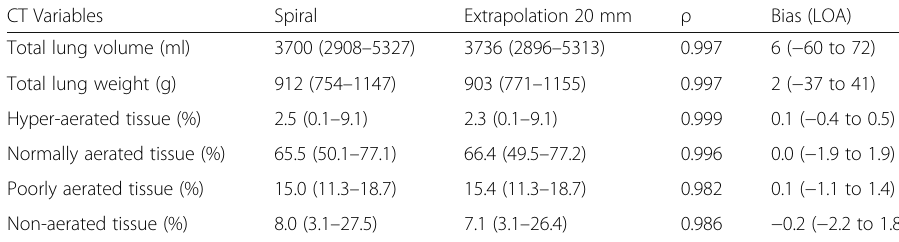
Table 3 Extrapolation method in humans CT Variables